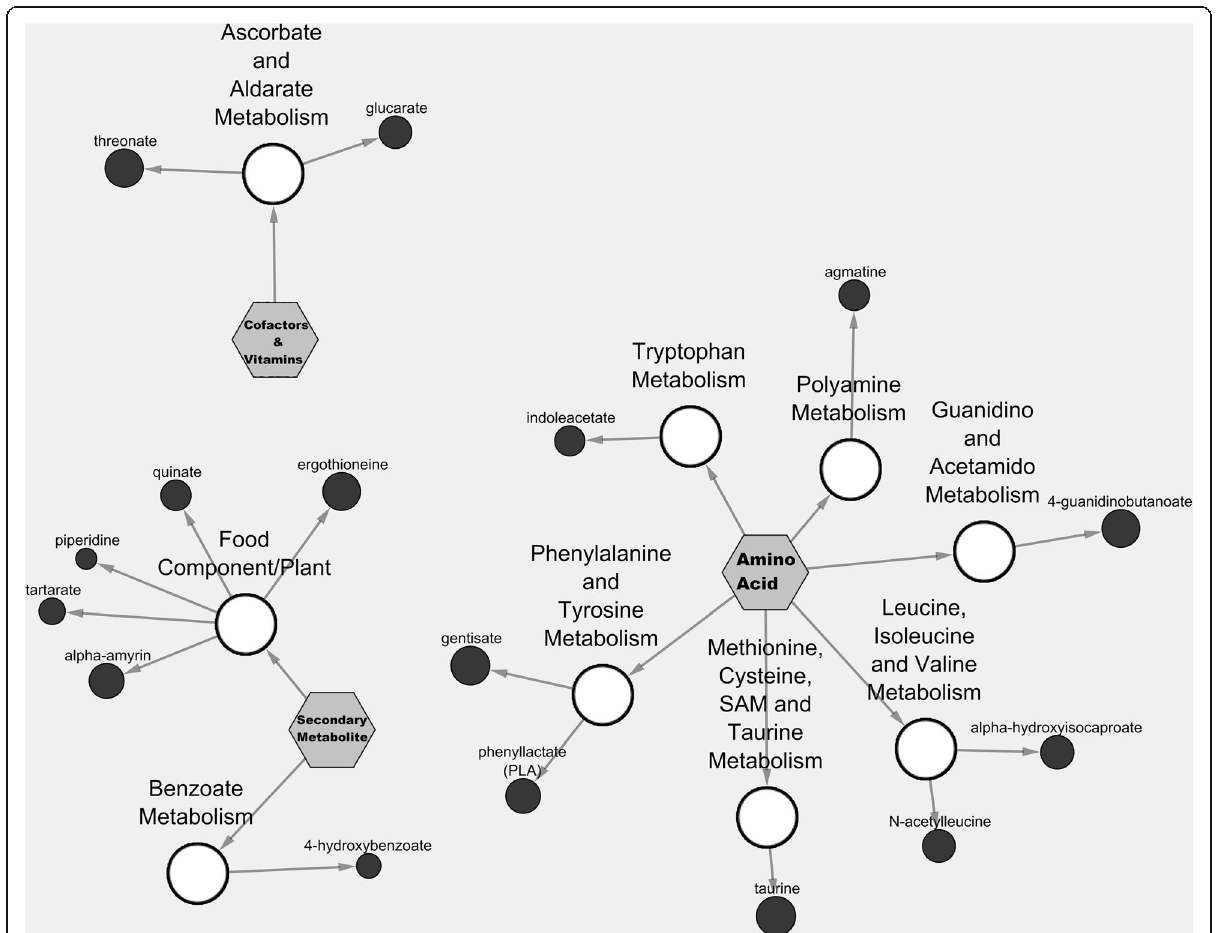
Fig. 4 Cytoscape visualisation of 16 newly identified metabolites from the rice bran metabolome. Medicinal and nutritional value for these bioactive compounds are described as deonted by 1 in Tables 1, 2 and 3. Pathway specific network visualization is shown for Calrose rice bran. Each metabolite is represented as a node (circle), extending from a central sub-metabolic pathway node. The central hexagon node represents the super metabolic pathway. Node size corresponds to the Z-score using the relative abundance mean value for all three